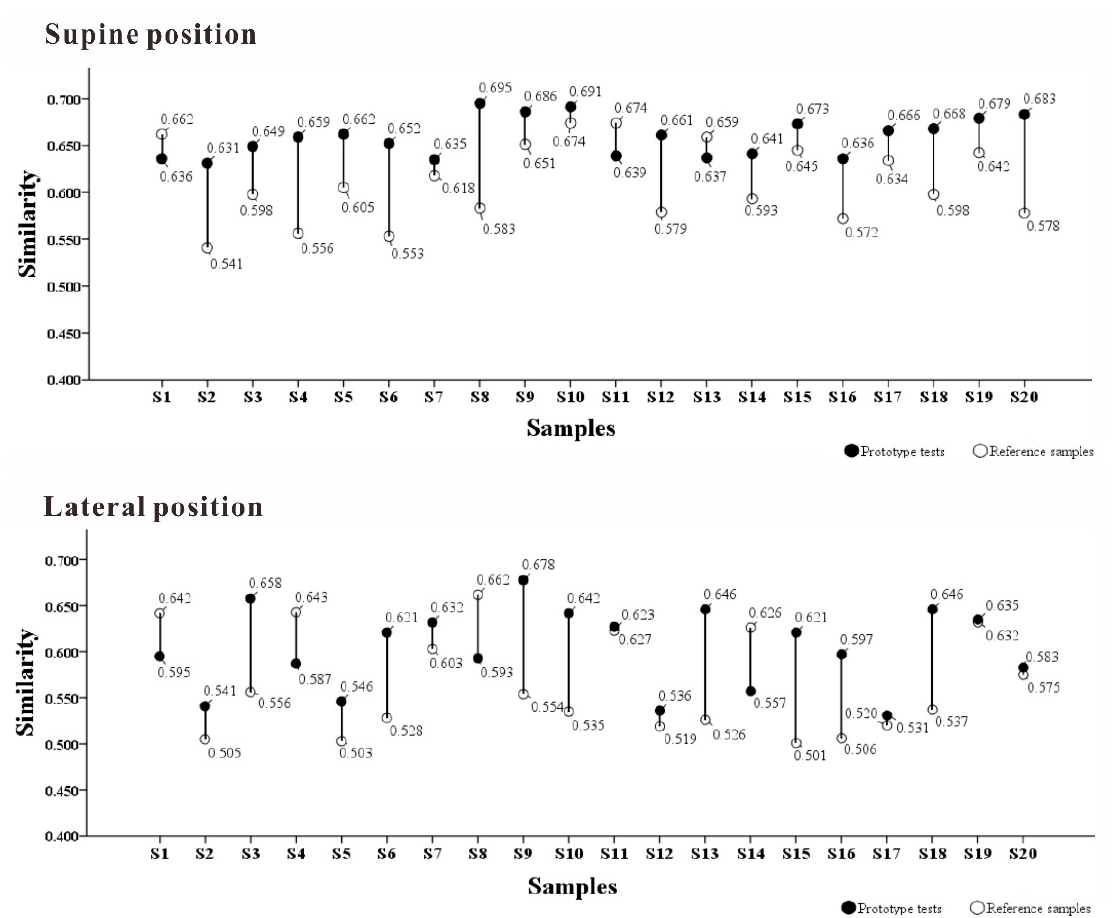
Figure 13. The similarity between the actual measured sample and the reference sample of the prototype and the ideal pressure distribution.